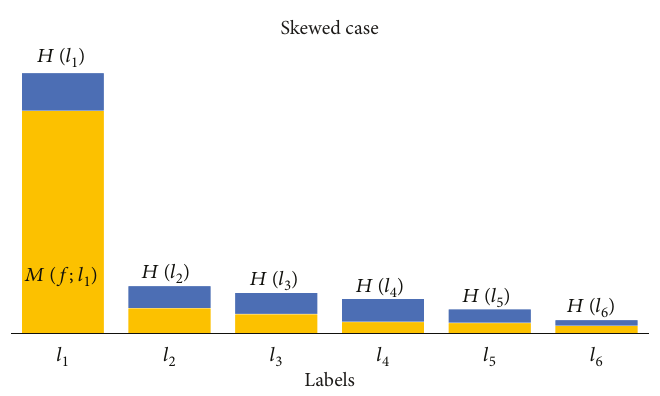
Figure 2: Score value calculation when label entropy values are